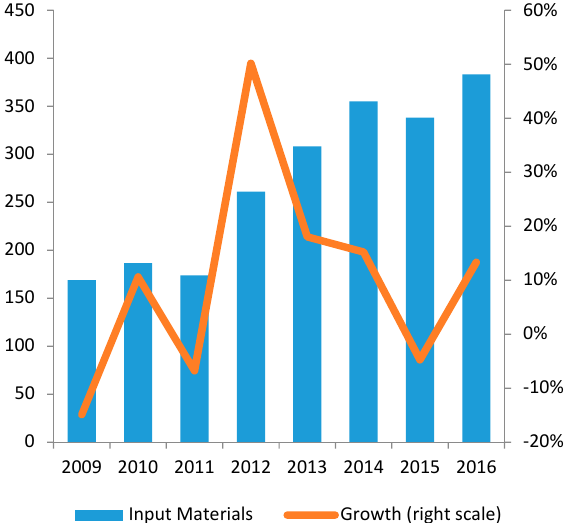
Figure 7. Import Volume of Input Materials in 2009–2016 (mil. USD).